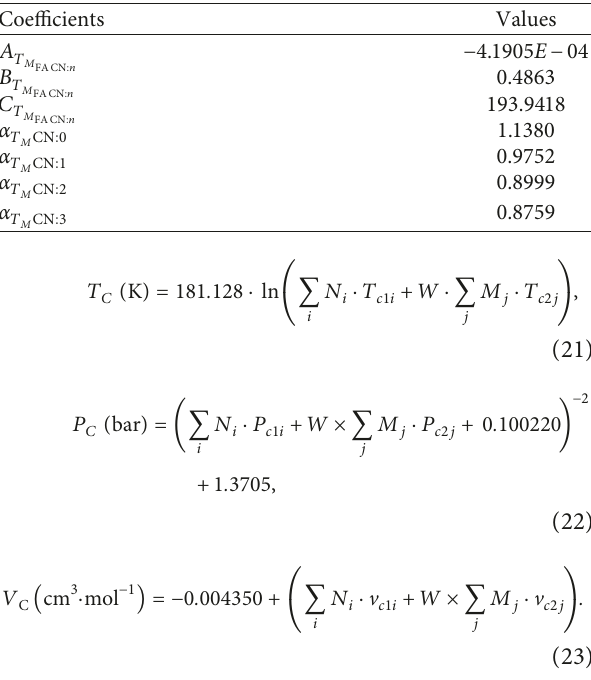
Table 10: Coefficients for the estimation of the normal melting point according to equation